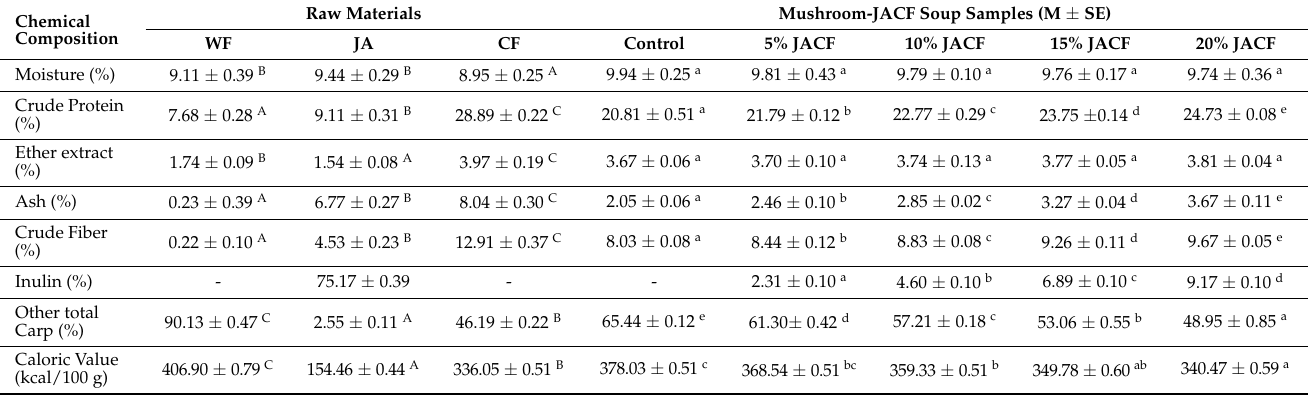
Table 2. Chemical compositions of the mushroom-JACF * soup samples (on a dry weight